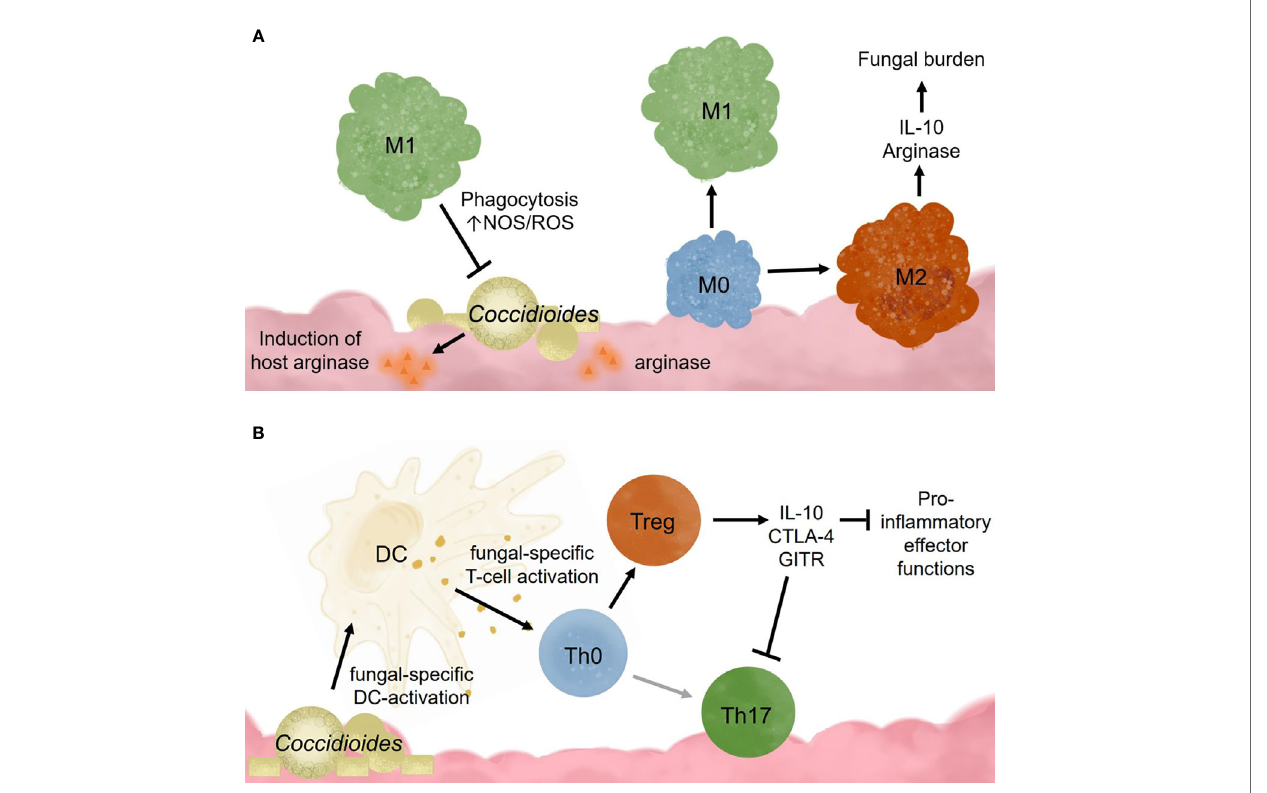
FIGURE 2 | Innate immune cell responses to Coccidioides in fl uence adaptive immune cell activation and effector functions. (A) Coccidioides may evade innate immune cell clearance and in fl uence immune functions. (B) Dendritic cells are critical for activating adaptive responses and in fl uencing adaptive immune cell population